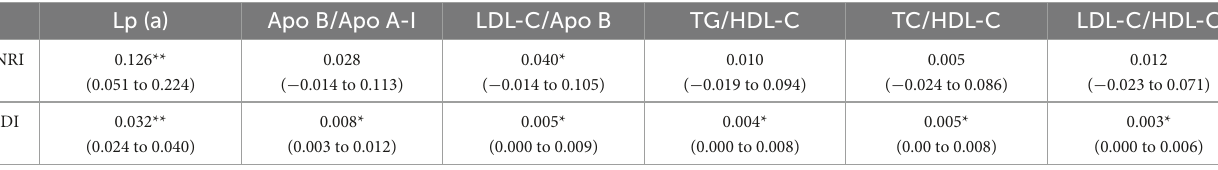
TABLE 3 Comparison of different lipid parameters for predicting CAD based on basic prediction model using the NRI and IDI with cut-off point at low ( < 50%)/intermediate (50–80%)/high risk ( > 80%) of CAD. Lp